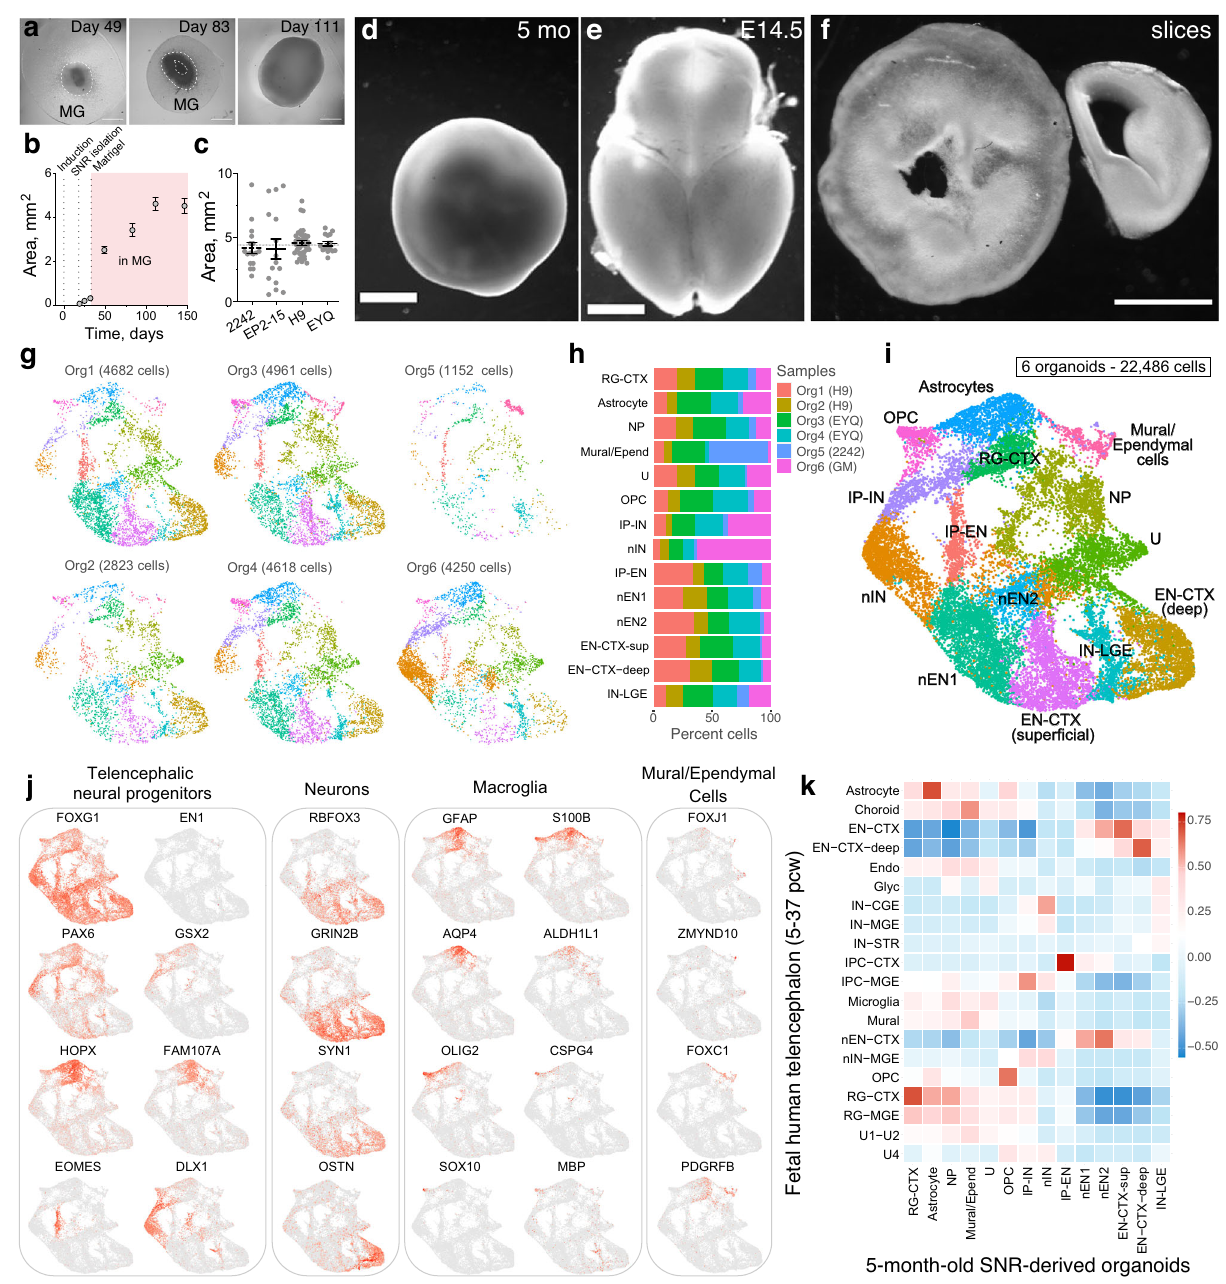
Fig.5|Reproducibilityanddiversityoftelencephaliccellsin5-month-oldSNR- derived organoids. a Images of SNR-derived organoids at day 49, 83, and 111 post SNR isolation. b Quanti fi cation of organoid sizes over time ( n =47 [day19], 46 [day25], 22 [day32], 25 [day49], 26 [day83], 26 [day111] and 25 [day146] organoids producedintwodifferentiationbatchesfromH9line). c Quanti fi cationofsizesof5- month-old SNR-derived organoids produced from different stem cell lines ( n =17, 15, 38, 15 organoids produced in 2 – 4 differentiation batches from 2242-5, EP2-15, H9, and EYQ2-20 lines, respectively). d – f Image of a 5-month-old SNR-derived organoid ( d ) and 350- μ m-thick organoid slice ( f ) in comparison with E14.5 mouse brain ( e ) and coronal mouse brain hemisphere slice ( f ). g UMAP visualizations of